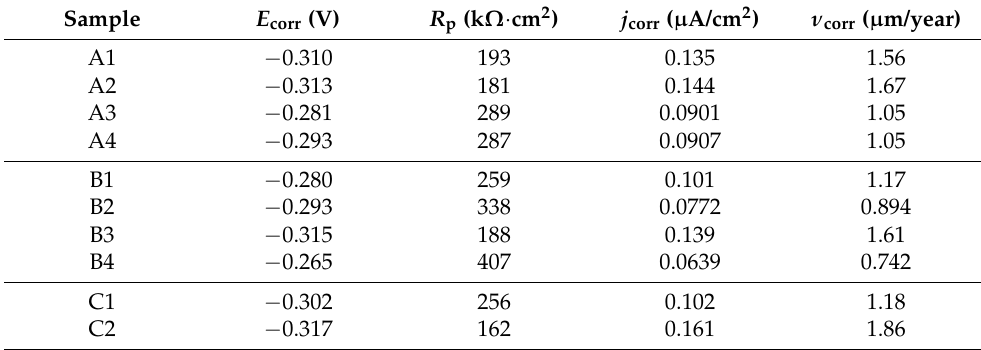
Table 2. Corrosion potential E corr , polarization resistance R p , corrosion current density j corr , and corrosion rates ν corr for the differing steel grades A, B, and